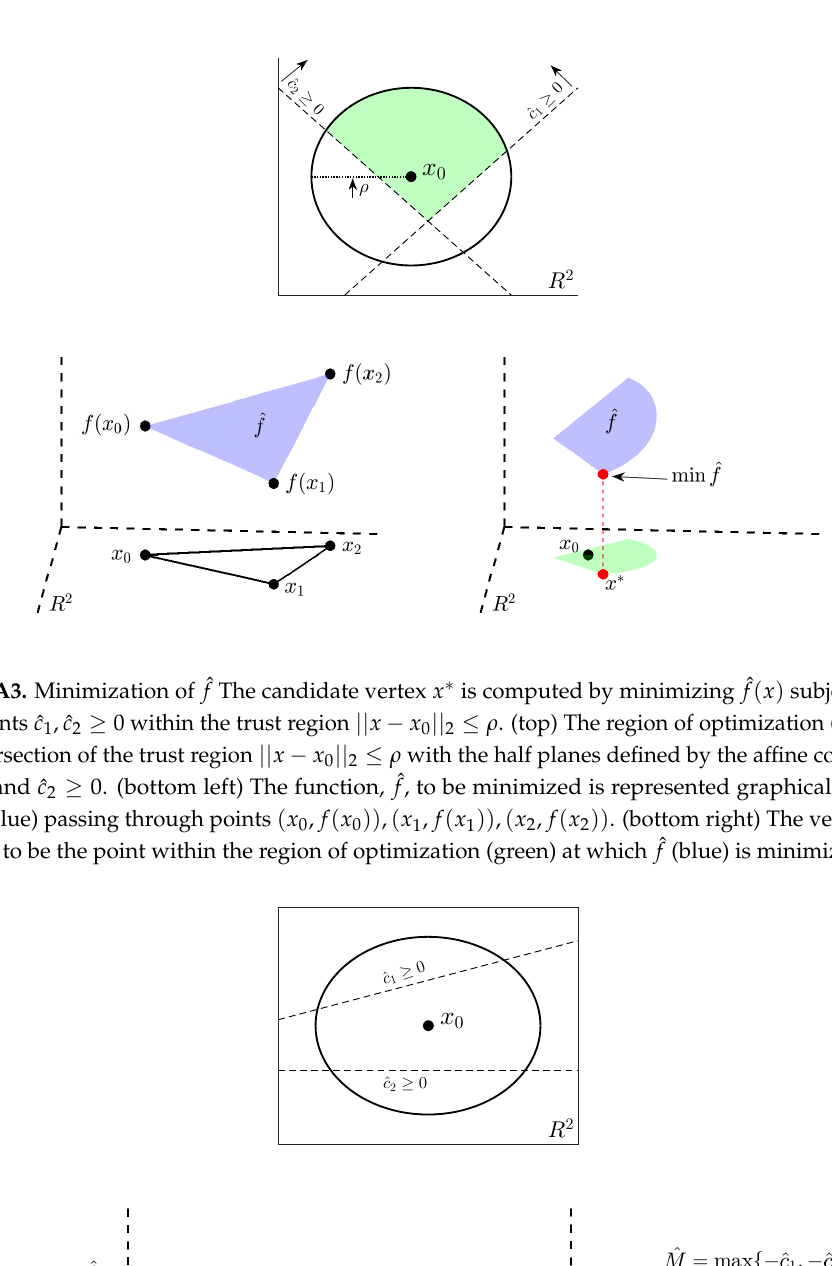
( x ) (blue) and − ˆ c ( x ) (green). (bottom 2 1